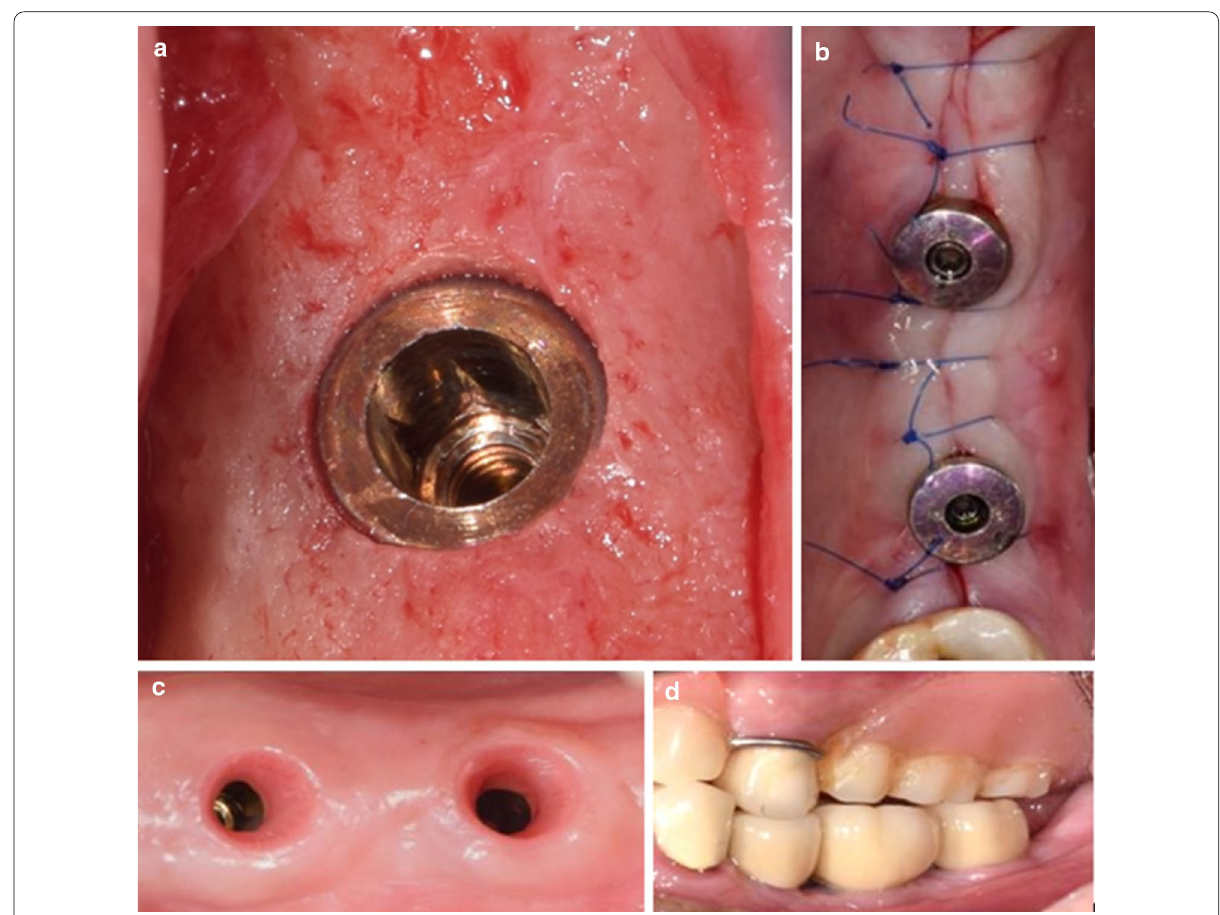
Fig. 2 Bone level implants. a Insertion up to the level of the bone crest, b healing abutments placed for a one-stage surgery, c and d healing and final